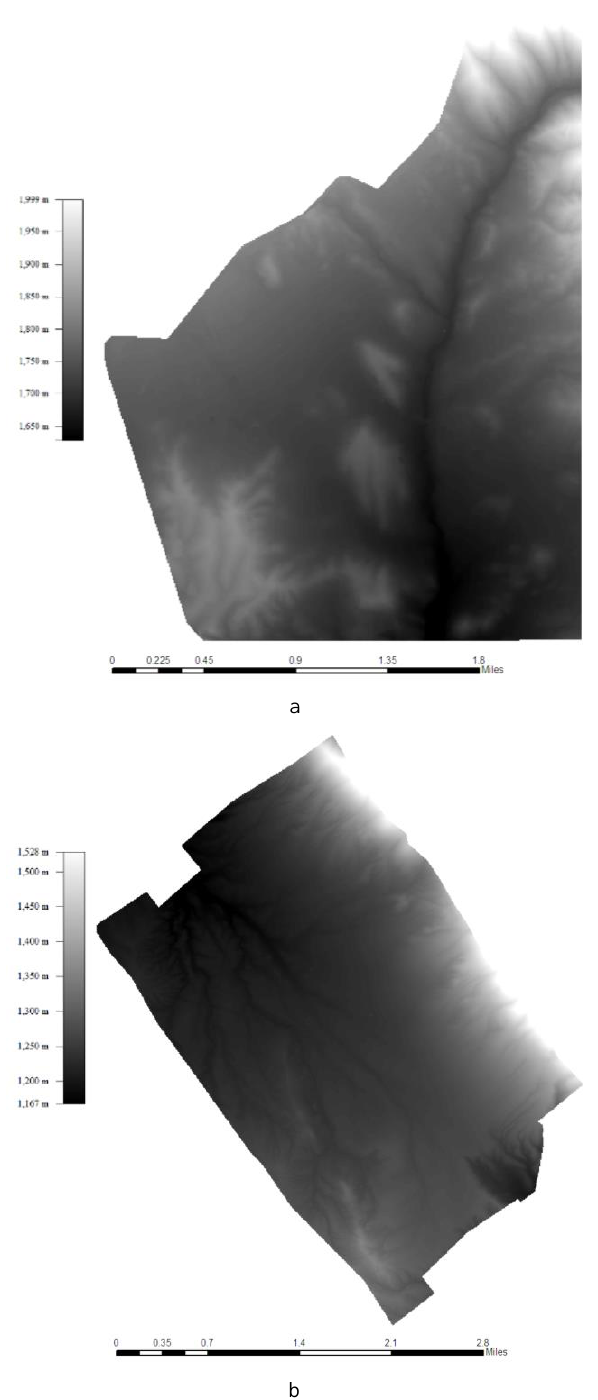
Figure 2. The Slope from REFDEM for a) Bomehen study area, b) Tazehabad study